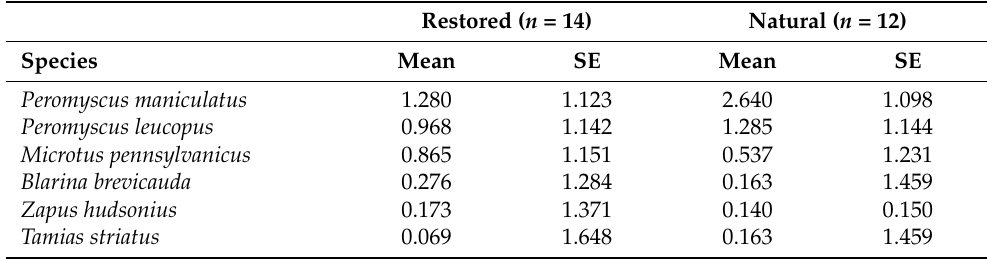
Table 1. Mean and standard error of the apparent abundance of unique small mammals per 100 trap nights by wetland type sampled in the summers of 2020 and 2021 in West Virginia, USA. Over both years, 3 species (woodland jumping mouse, masked shrew, and southern flying squirrel) were only observed in natural wetlands and were excluded from the